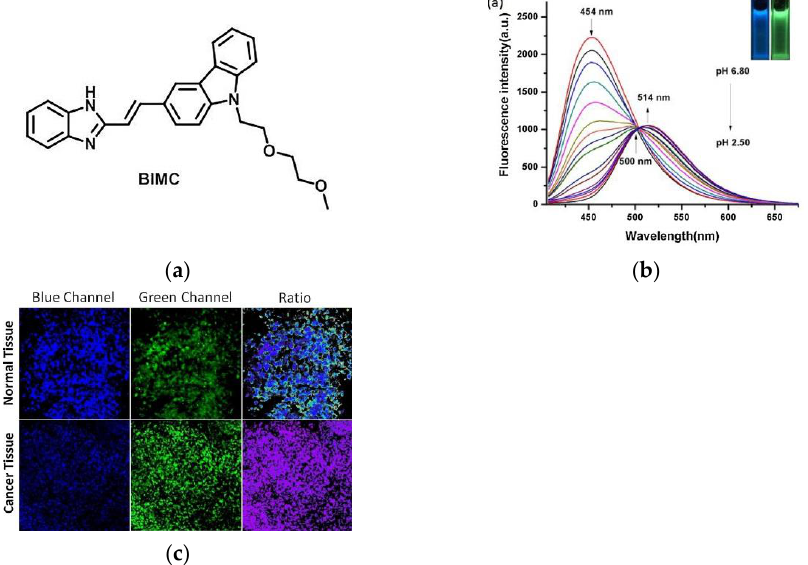
Figure 14. ( a ) Structure of probe BIMC; ( b ) Fluorescence spectra of BIMC with decreasing pH; ( c ) Two-photon ratiometric fluorescence images of pH in mouse liver slices. Reproduced with permission from [75]. Copyright 2018 Elsevier B.V.